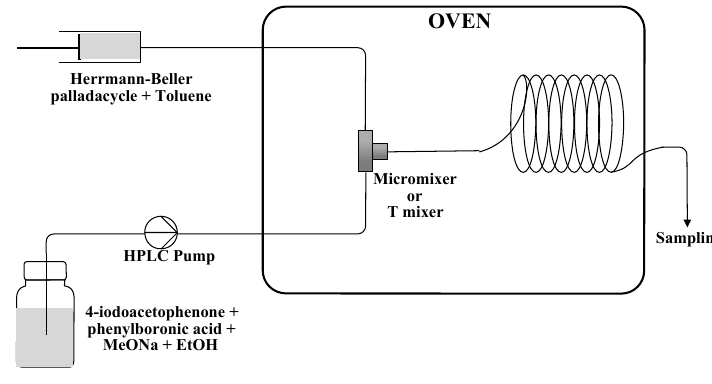
Figure 6. Flow test experimental